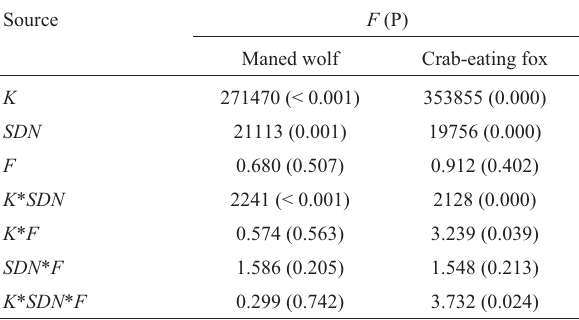
Table 2 - F -values and their significance levels, from the factorial ANOVA applied to understand the components affecting time to extinc- tion ( Te ) in the two species analyzed, including variation in carrying ca- pacity ( K ), in standard deviation of population size ( SDN ) and in the inbreeding coefficient ( F ) and their first and second order